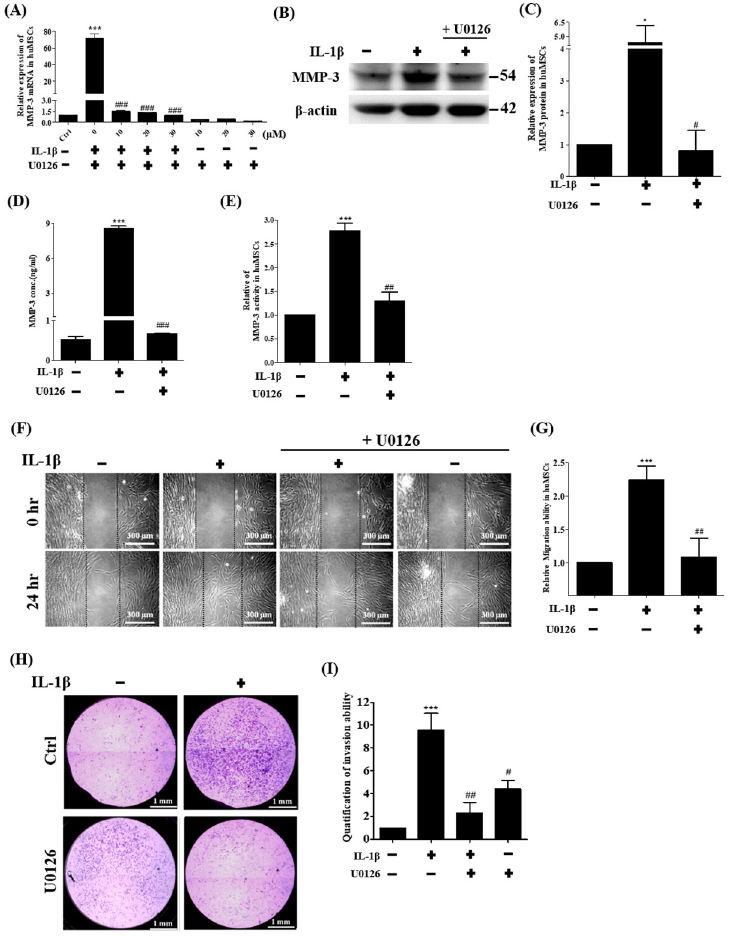
Fig 5. Effects of ERK1/2 pathway on IL-1 β -mediated MMP-3 expression, cell migration and cell invasion. (A) Quantitation of changes in gene expression of MMP-3 detected by real-time PCR after ERK1/2 inhibitor U0126